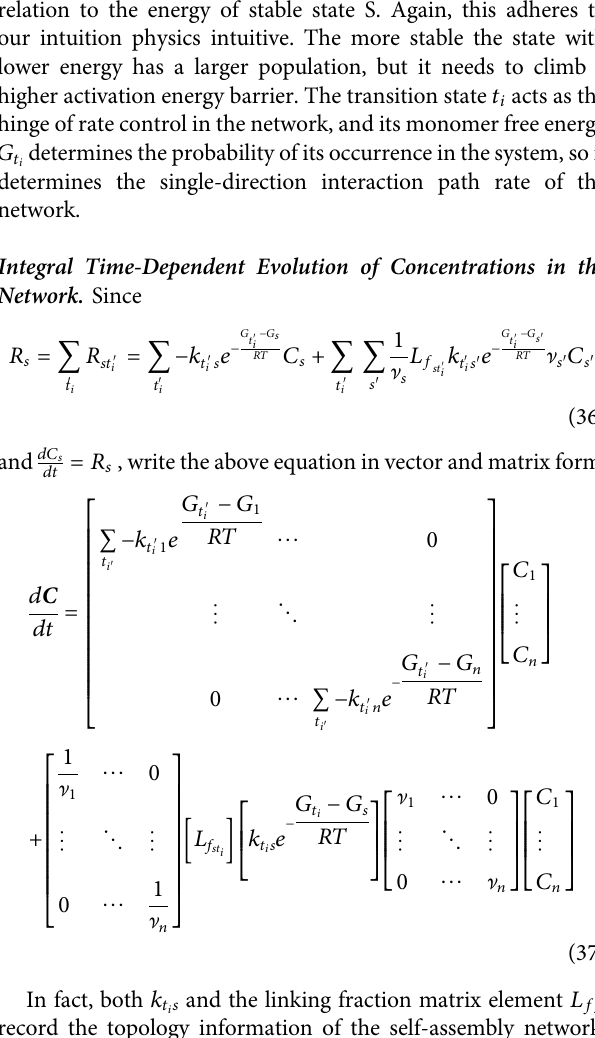
the inter-state transformation kinetics in PD-L1 system. In Figure 7 , the S 1 , S 2 and S 3 denote the initial state 1 (4Z18 apo form dimerization), the initial state 2 (IS PP apo form dimerization), the fi nal state (5J89 holo form dimerization) respectively, T 1 and T 2 denote the three-body separation transition state and the “ BMS-202 inserting process ” transition state respectively. The relative free energy of the monomer in each state used in GITR theory is equal to the corresponding Δ G bind of state divided by the monomer number (according to Eq. 26 ), marked in black in Figure 7 .